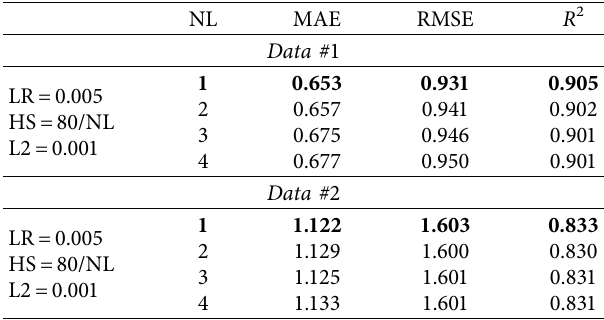
Table 4: Infuence of diferent GRU layers on the